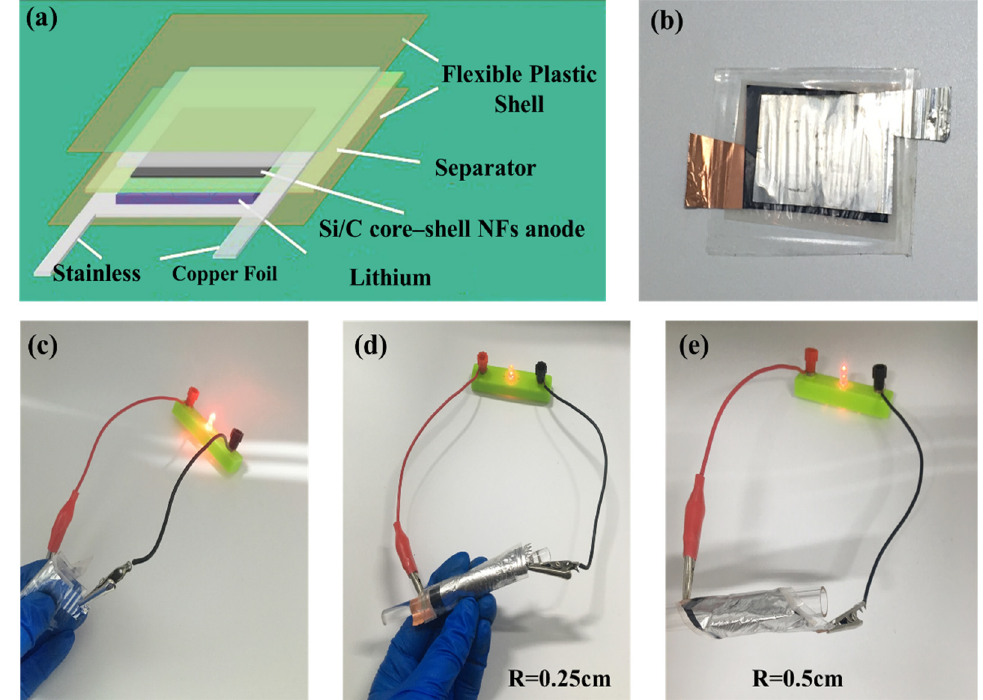
Figure 6. ( a ) Scheme of a flexible battery using Si/C core–shell mat as the anode and commercial lithium film as the counter electrode. Digital photographs of a flexible battery ( b ) and an LED lit by the flexible battery under bending ( c ) and enwinding ( d , e )